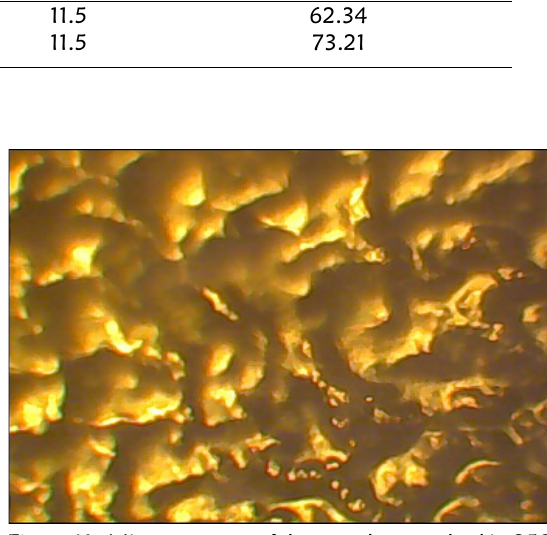
Figure 12: Microstructure of the sample quenched in 250 m1 of cottonseed oil, 250 ml of neem seed oil,